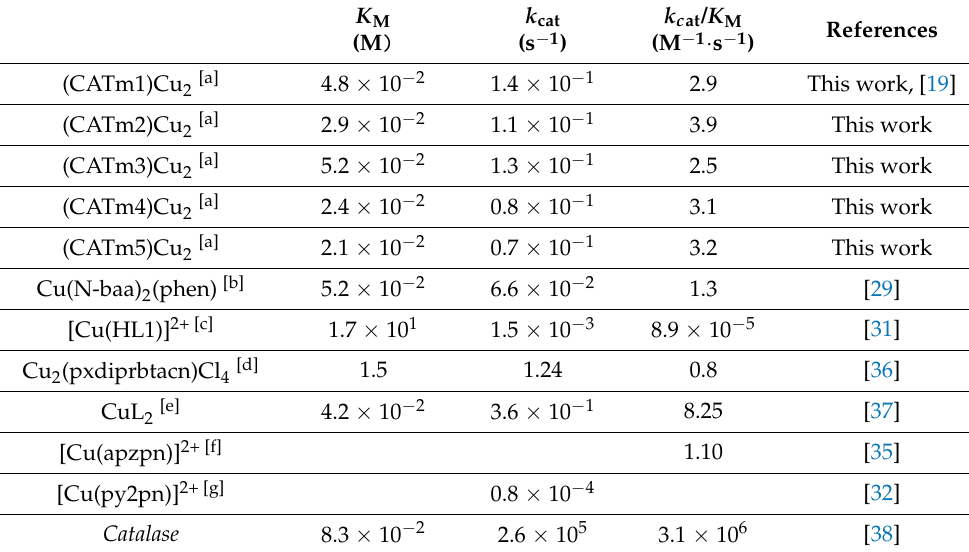
Table 3. Parameters describing the catalysis of H 2 O 2